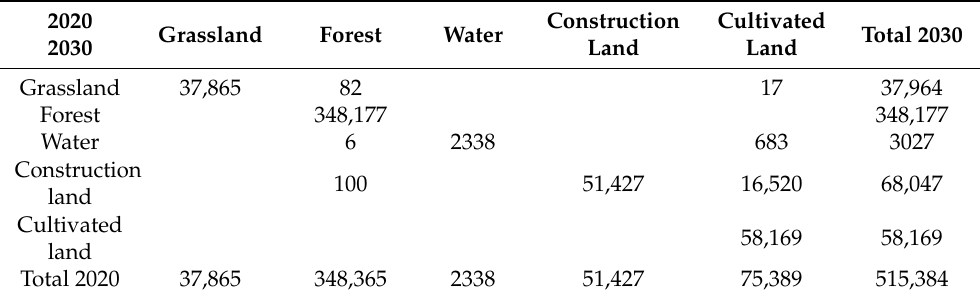
Table 11. Land-use area transfer matrix under the natural development scenario of the ECA in western Beijing from 2020 to 2030 (unit: hm 2 ).